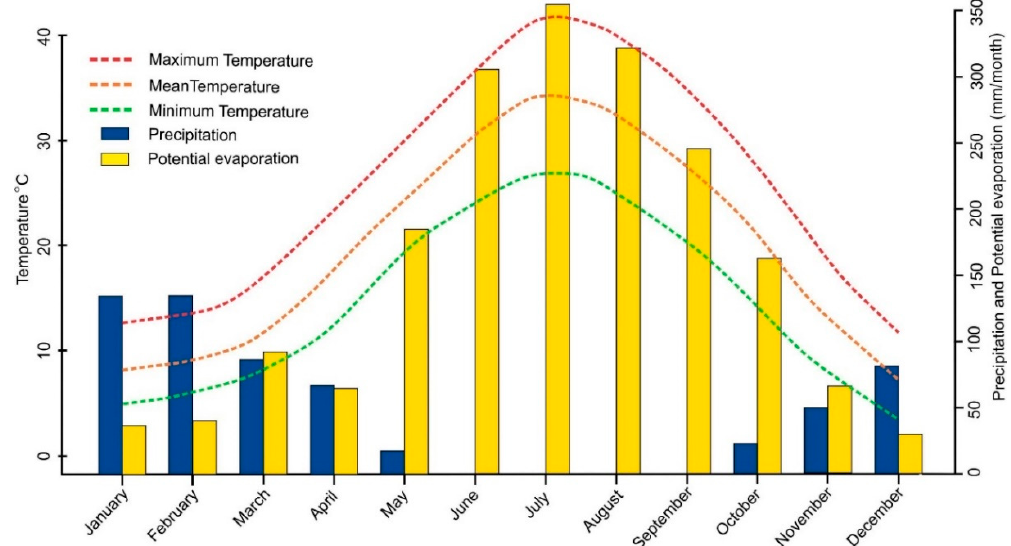
Figure 2. Monthly data of rainfall, evaporation, and temperature, collected at the Zakho meteorological station for the period 2002–2010; data modified from [48].